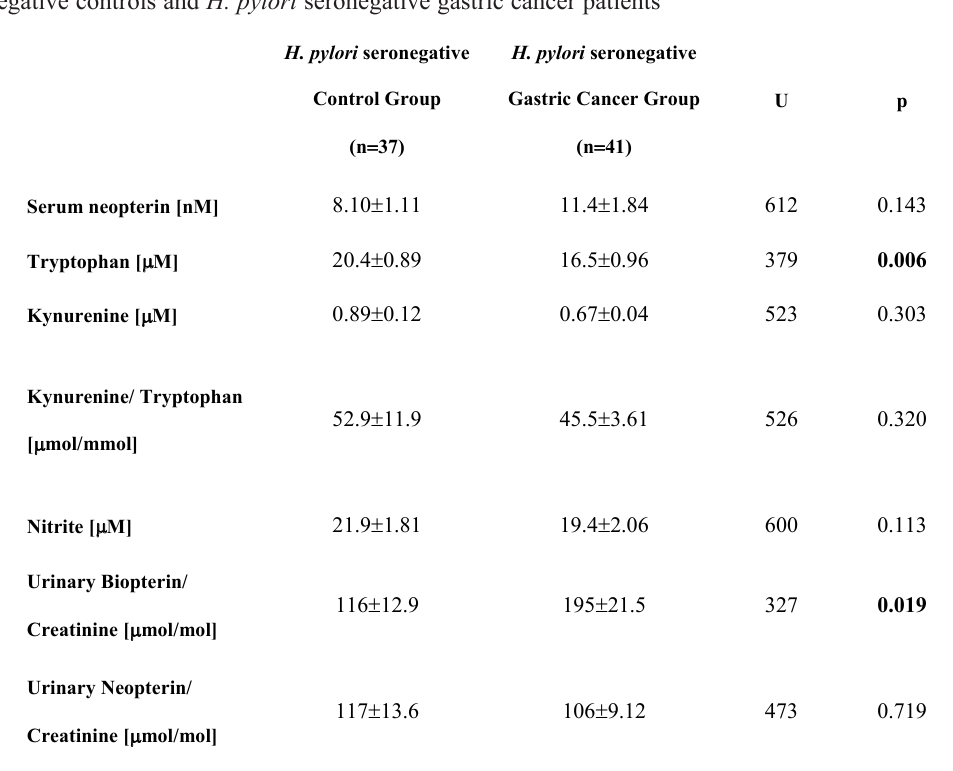
Table 2. Comparison of neopterin, tryptophan, kynurenine, nitrite, biopterin levels [mean ± SEM] of H. pylori seronegative controls and H. pylori seronegative gastric cancer